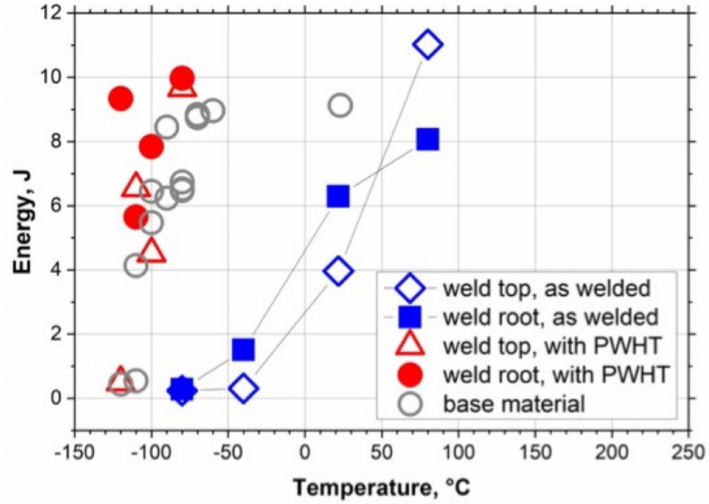
Figure 16. Charpy test results of a 40 mm EB weld. The Charpy specimens were fabricated from the top and root of the weld with the notches centered to the fusion zone. The tests have been performed in the condition after welding (without PWHT) and after a PWHT (980 ◦ C/30 min + air quenching + 750 ◦ C/2